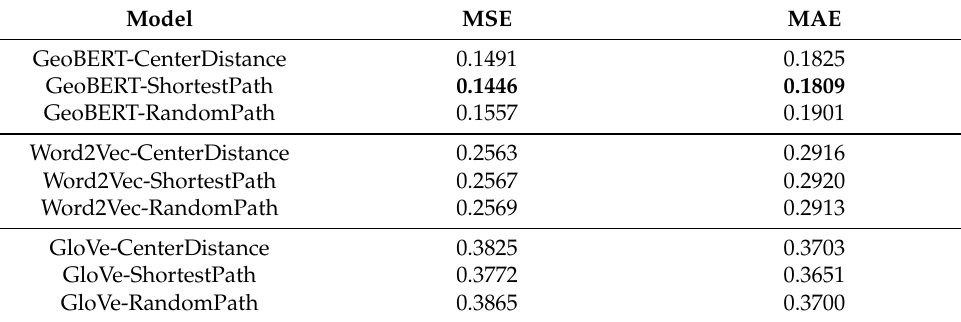
Table 11. Evaluation on passenger flow prediction.